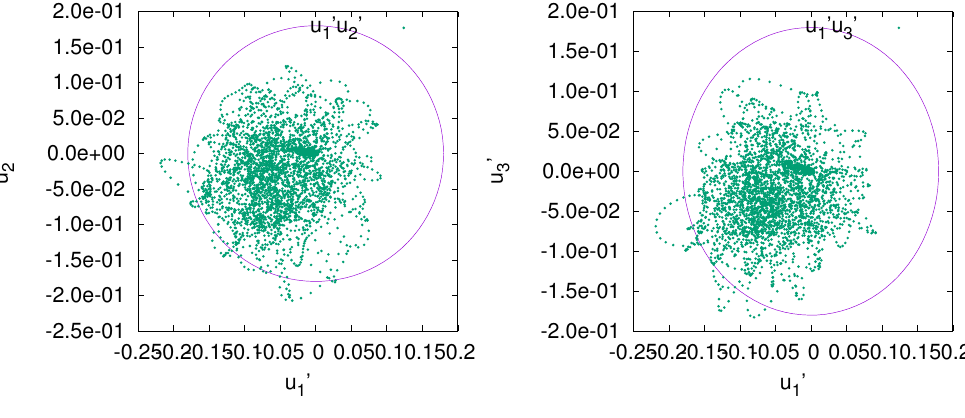
Figure 17. Correlation maps between velocity component pairs ( u 1 , u 2 ) ( left ) and ( u 1 , u 3 ) ( right